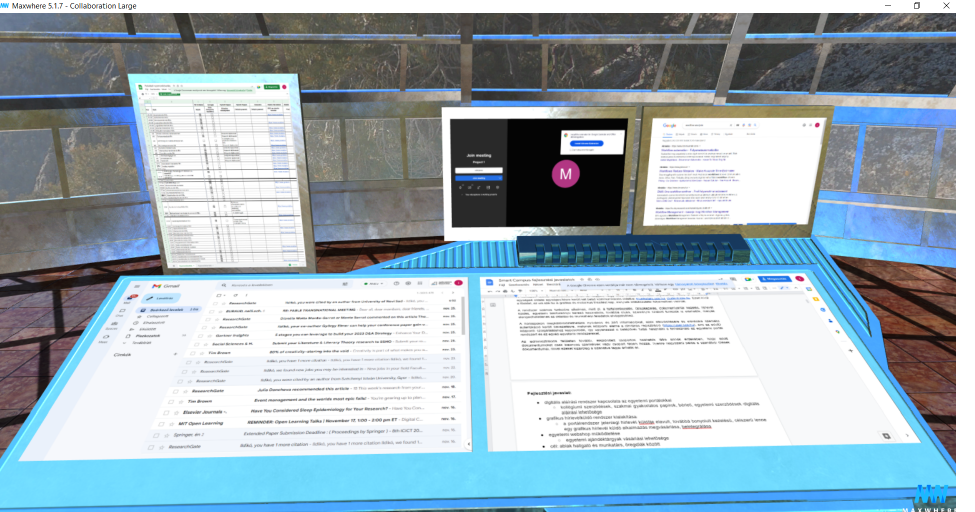
Figure 2. Screenshot of the MaxWhere virtual reality. The five digital contents are displayed on the five smartboards of the virtual table. There is a spreadsheet on the upper left part of the workstation, then there is a smartboard for the online meeting, and next to it, there is a web browser. On the horizontal part of the table, the e-mail client and a shared document are displayed according to the users’